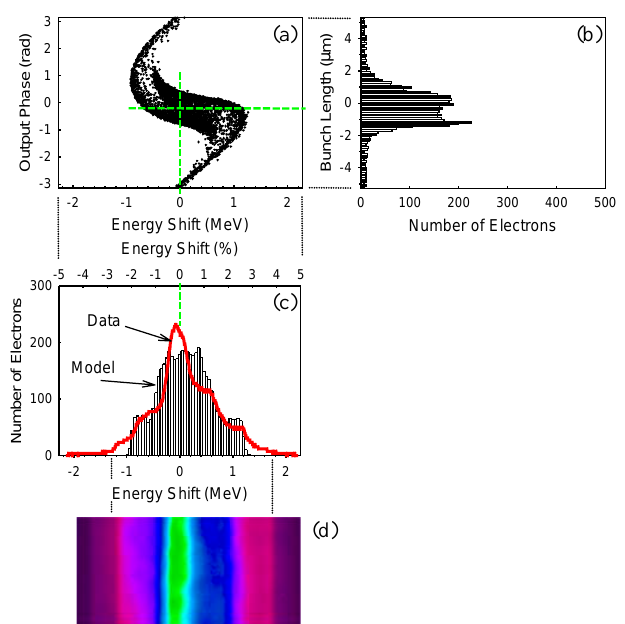
FIG. 6. (Color) Comparison of staging results with model for phase delay 310 ± from Fig. 3. (a) Model-predicted electron out- put phase versus electron energy, (b) model-predicted electron bunch length, (c) electron energy spectrum, and (d) raw spec- trometer output for data plotted in (c).